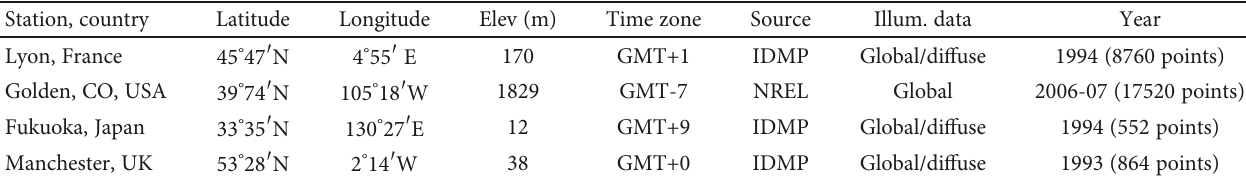
Table 2: Measured irradiance and illuminance data of selected